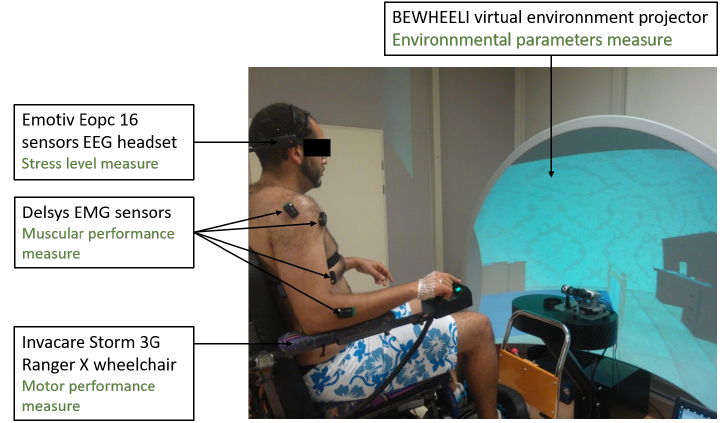
Figure 2. The setup of the BEWHEELI environment.